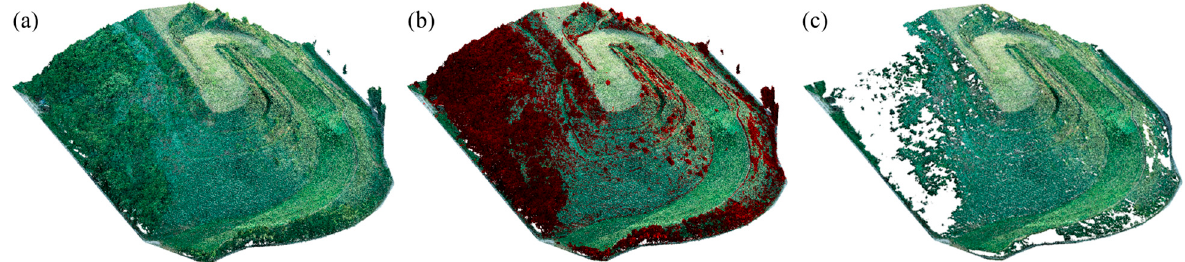
Figure 4. Point cloud generated from photos showing ( a ) green vegetation visible on the landfill, ( b ) the process of vegetation filtration, and ( c ) the surface of the site after